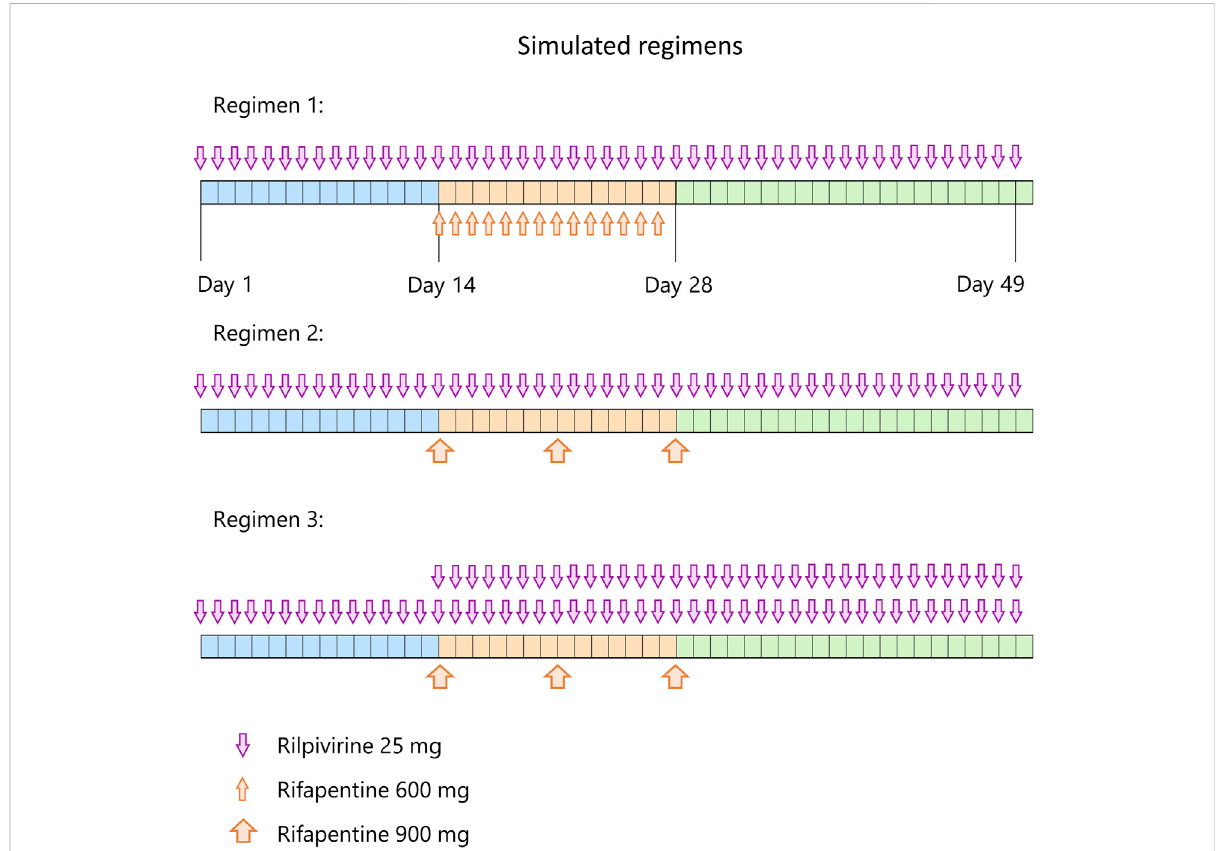
FIGURE 1 Simulated regimens. Each regimen starts with 14 days of rilpivirine 25 mg once daily (blue period), followed by 14 days (orange period) of rilpivirine 25 mg once daily and 600 mg rifapentine once daily on regimen 1, rilpivirine 25 mg once daily and once weekly 900 mg rifapentine on regimen 2, and rilpivirine 50 mg once daily and once weekly 900 mg rifapentine on regimen 3. On the third period (green), rifapentine ’ s administration is ceased but rilpivirine is maintained with the same dose strategy as the previous period during 21